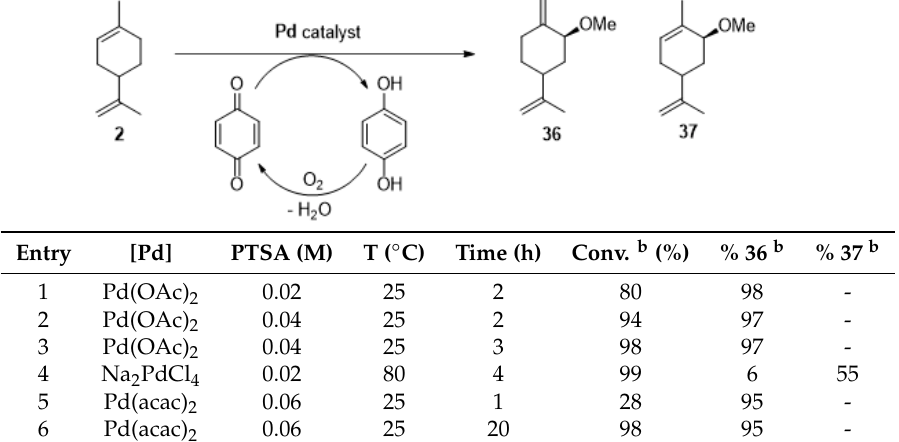
Table 13. Oxidation of limonene 2 catalyzed by palladium complexes in methanol a (adapted from reference [52]).